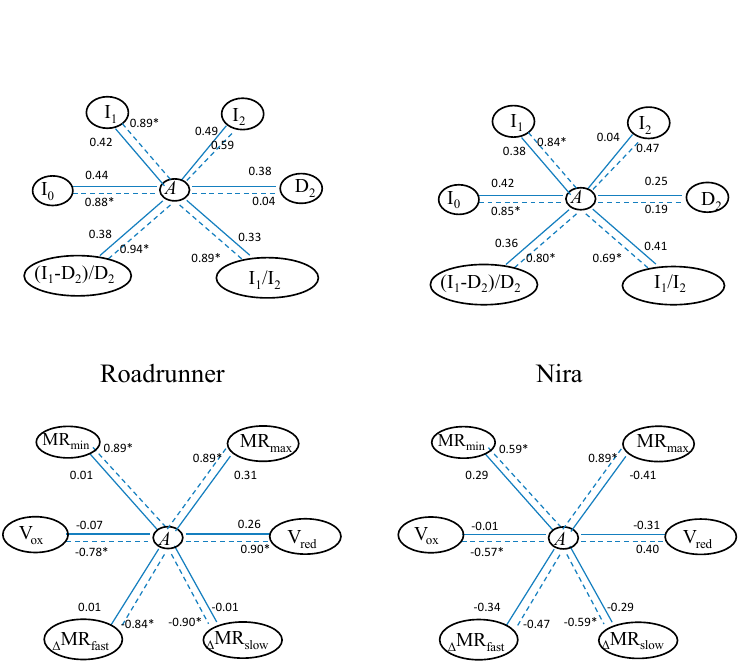
Figure 10. Pearson correlation coefficients ( r ) between delayed fluorescence parameters and CO 2 assimilation ( A ) and between modulated reflection at 820 nm and CO 2 assimilation ( A ) (correlations significant at p < 0.05, n = 6). Relations between parameters marked by a solid line were calculated for plants in control conditions, and those marked by a dotted line were calculated for plants under 30% FWC.